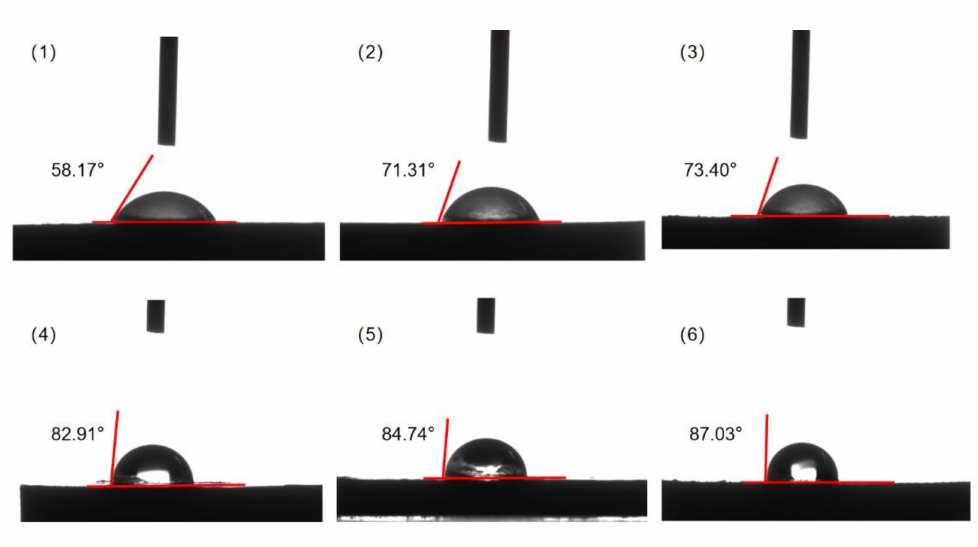
Figure 3. Photographs of contact angle of ( 1 ) unmodified hectorite, ( 2 ) hectorite-C18, ( 3 ) hectorite- C18-V, ( 4 ) hectorite-2C18, ( 5 ) hectorite-2C18-V, ( 6 ) hectorite-2C18-2V.